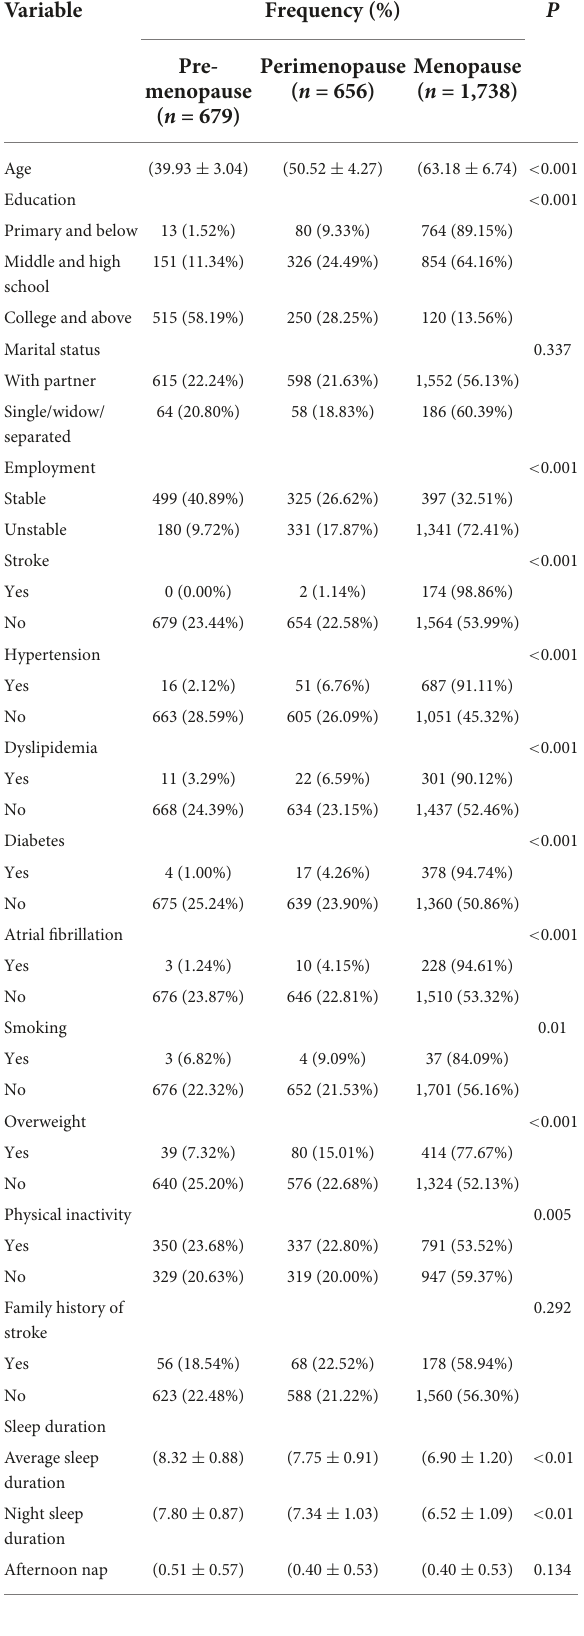
TABLE 1 Sociodemographic characteristics and stroke risk